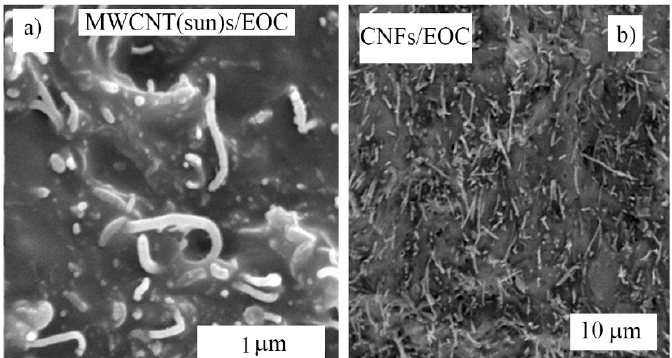
Figure 3. SEM micrographs of a surface of layers made of organic and inorganic fillers. The respective fillers are denoted in the images.